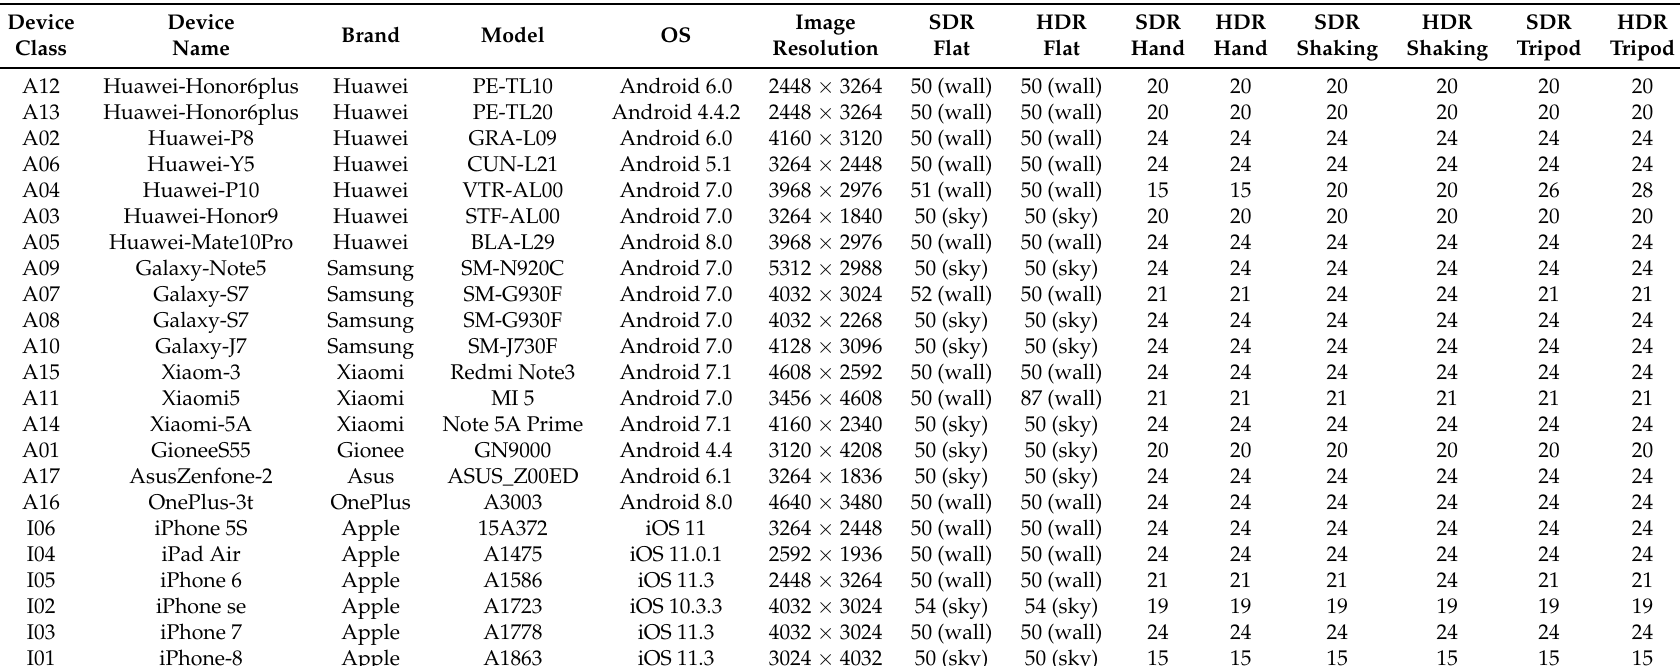
Table 1. Characteristics of the employed devices and captured